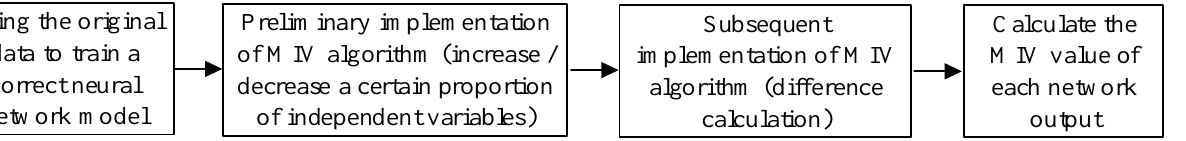
Figure 1. Flow chart of correlation calculation based on MIV algorithm.